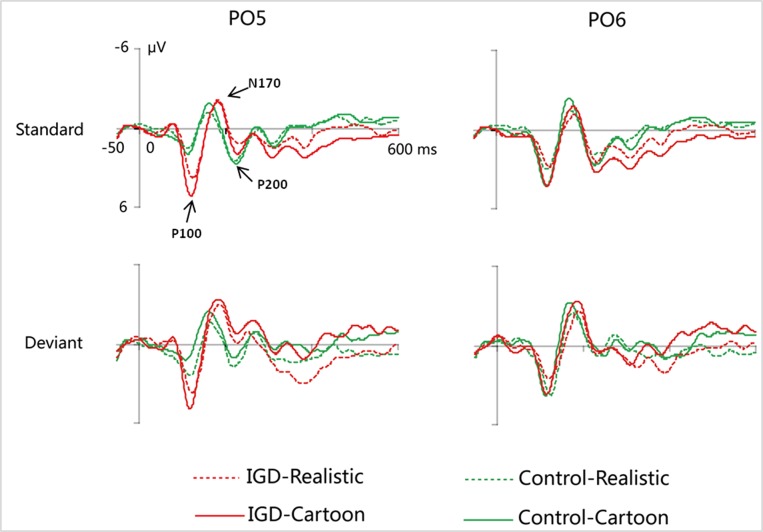
Grand-averaged P100, N170, and P200 waveforms for cartoon and realistic faces in the IGD and control groups at the PO5 and PO6 electrodes. IGD, Internet gaming disorder group; Control, control group; Standard, standard stimuli; Deviant, deviant stimuli; Realistic, realistic faces; Cartoon, cartoon faces.